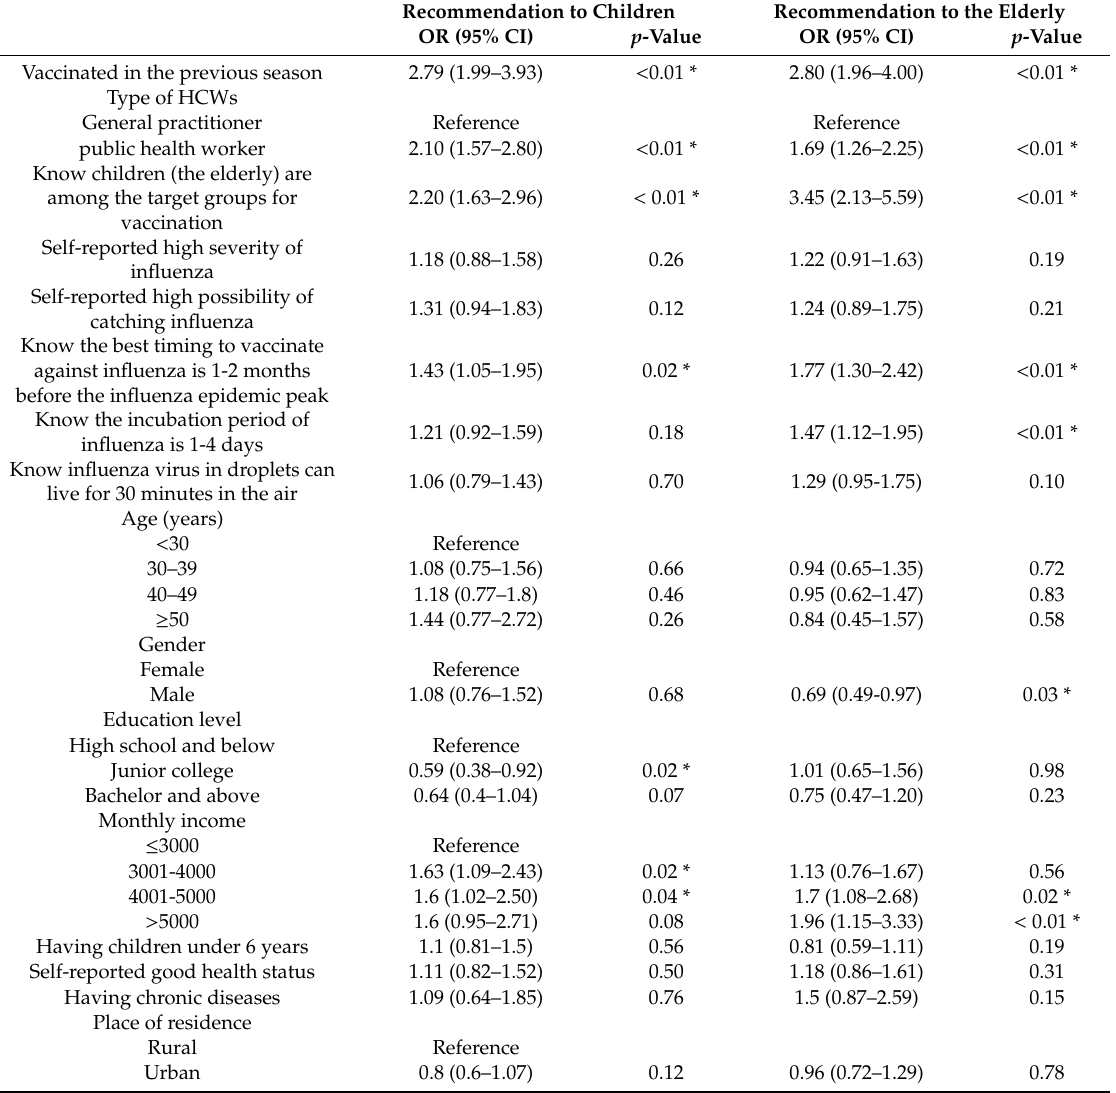
Table 5. Influencing factors of HCWs’ vaccination recommendation to children or the elderly (multiple logistic